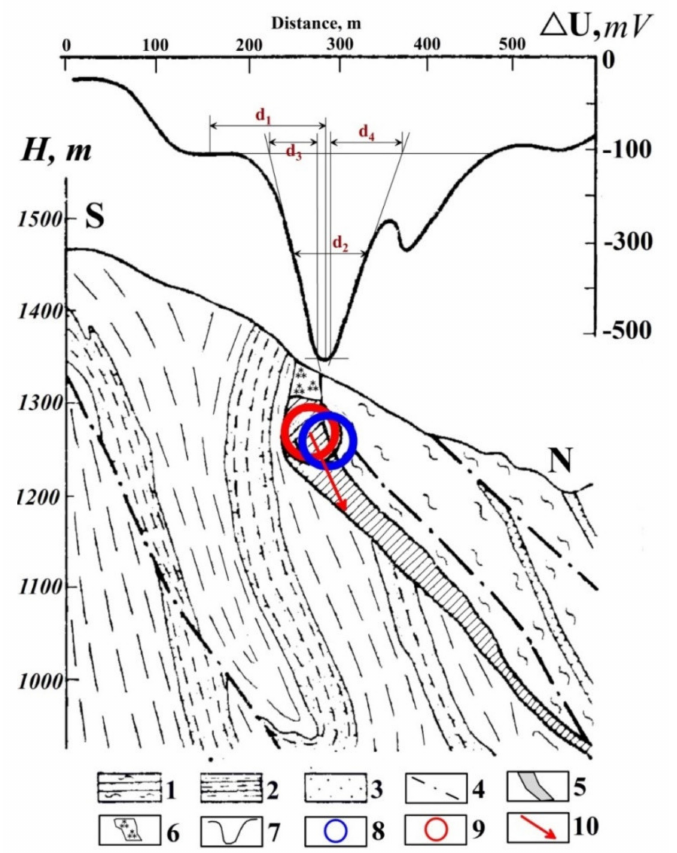
Figure 8. Results of quantitative interpretation of SP anomaly in the area of Filizchay copper- polymetallic deposit in the southern slope of the Greater Caucasus (Azerbaijan) (revised after [72]). (1) Interbedding of sands and clay schists, (2) clay schists with the flysh packages, (3) clay sandstone, (4) faults, (5) massive ore of pyrite-polymetallic composition, (6) oxidized ore, (7) SP curves, location of anomalous source: (8) without calculation of the inclined relief influence, (9) after introducing correction for the surface relief, (10) direction of the self-potential